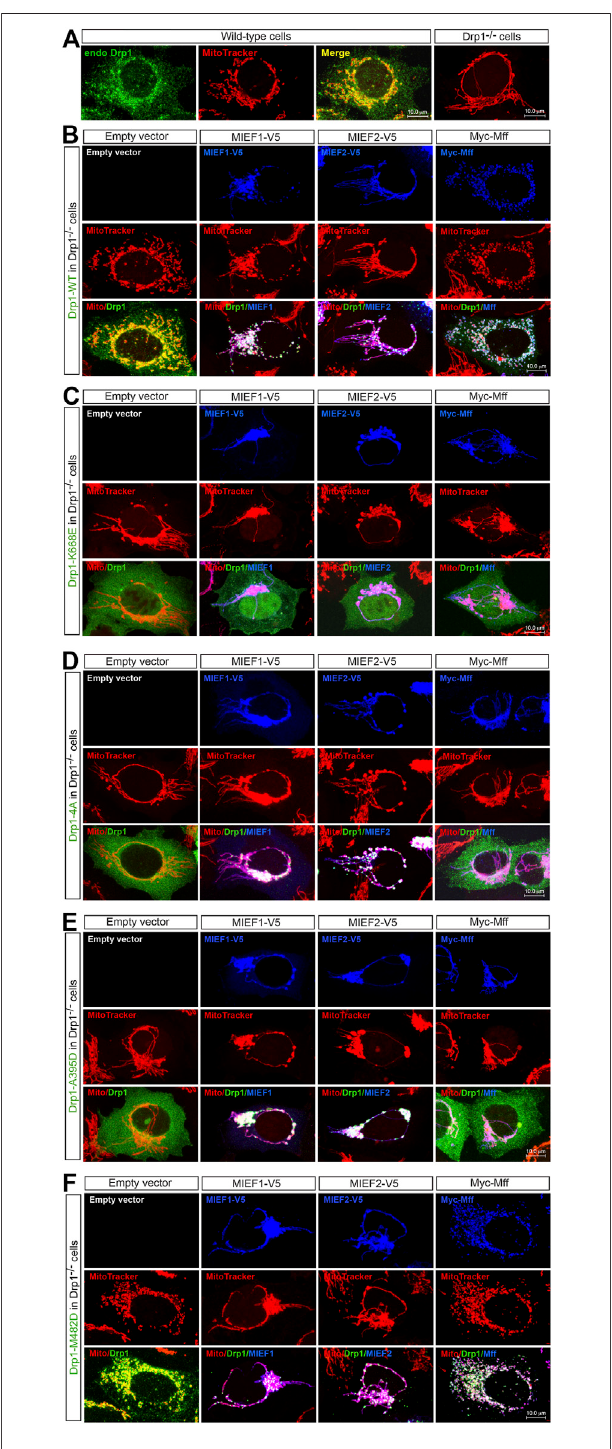
FIGURE 4 | The self-assembly state of Drp1 differentially regulates its mitochondrial recruitment through MIEFs or Mff (A) Confocal images of mitochondrial morphology and endogenous Drp1 distribution in wild-type (WT) or Drp1 − / − 293T cells stained with MitoTracker (red) and anti-Drp1 (green) antibody. (B – F) Confocal images of mitochondrial morphology and exogenous Drp1 distribution in Drp1 − / − 293T cells co-transfected with Drp1-